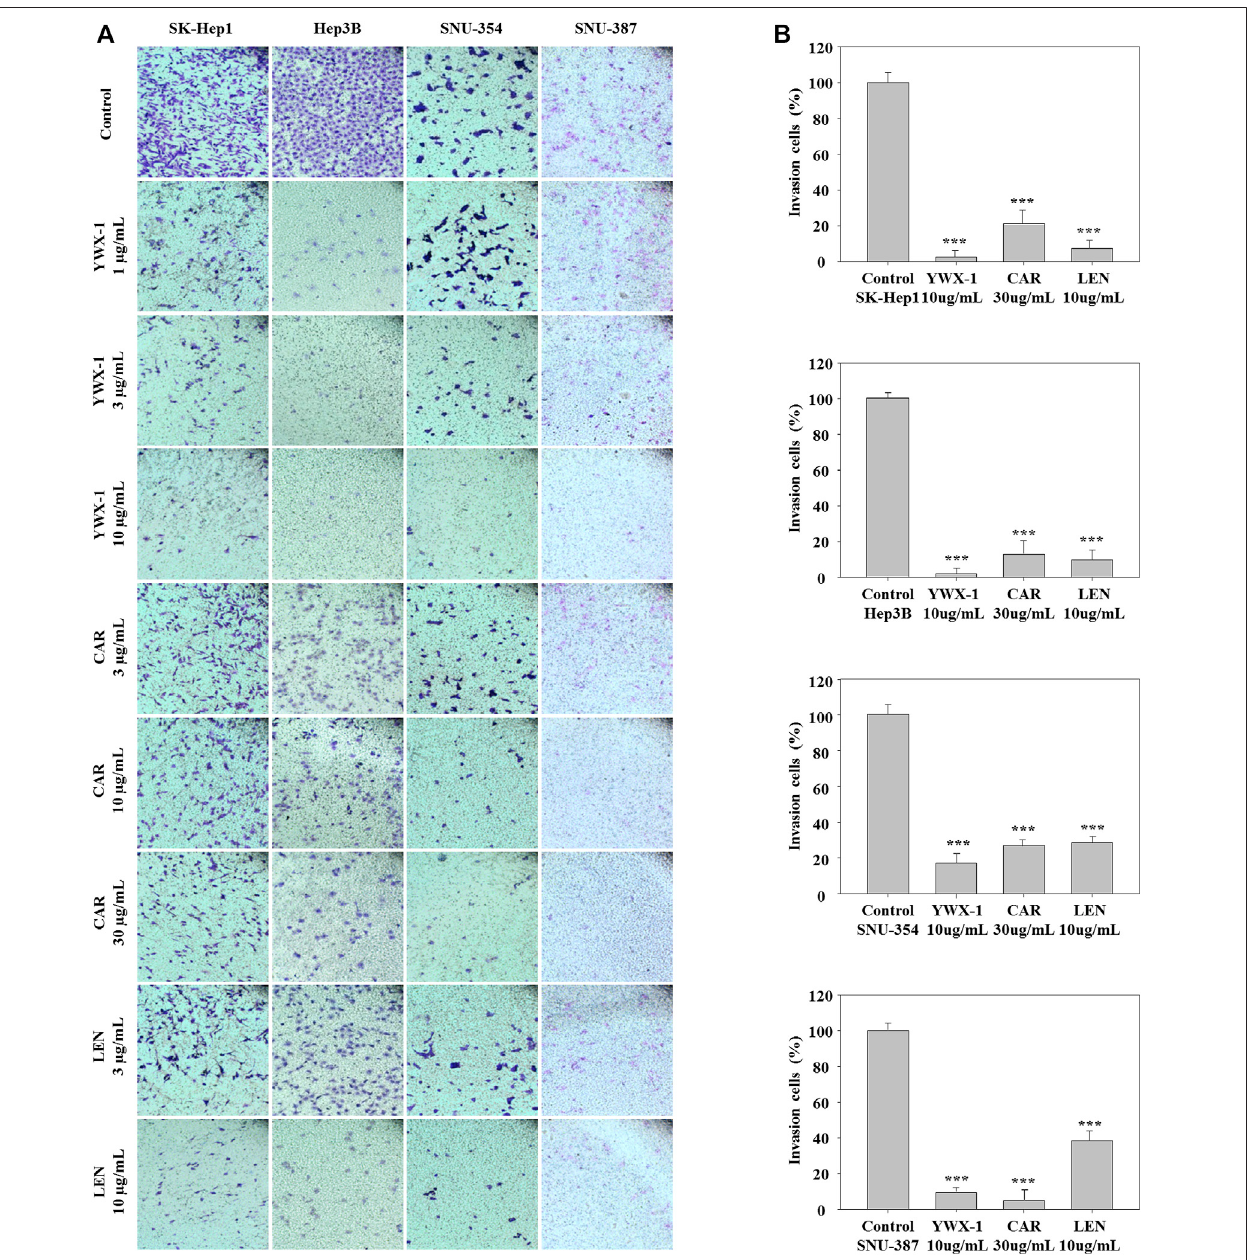
FIGURE5| Carrimycin(CAR)andmonomericisovalerylspiramycinI(YWX-1)inhibittheinvasionofhepatocellularcarcinomacells. (A) SK-Hep1,Hep3B,SNU-354, and SNU-387 cells were treated with different concentrations of carrimycin and monomeric isovalerylspiramycin I. Cell invasion was observed by an optical microscope ( × 200magni fi cation). (B) Statistically signi fi cant differences are indicated when compared with control group. Data represented as mean ± standard deviation of three independent experiments (n (cid:2) 3).